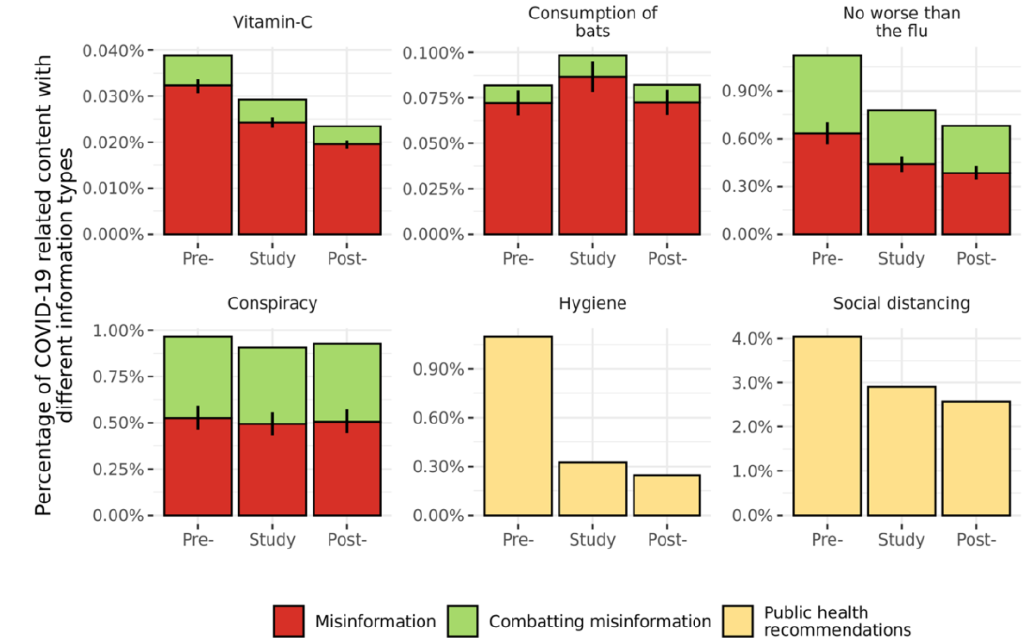
Supporting Figure 1. Relative frequencies of COVID-19 related information. The percentage of all COVID-19 related content that includes reference to a particular theme in the pre-March 26, March 26 – April 3, and post-April 3 periods. Confidence intervals are shown only for the tweets where a random sample was manually categorized, and the results extrapolated to all tweets in the corpus. Note that the manual coding was done only during the Study